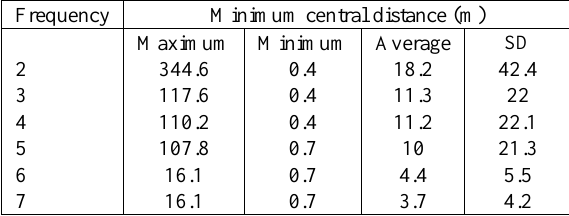
Table 3. Evaluation of minimum central distance index in